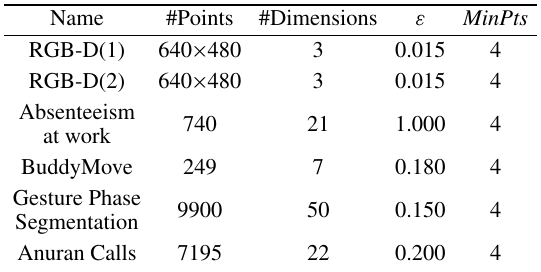
Fig. 5 Three features of synthetic datasets. Table 2 Real-world